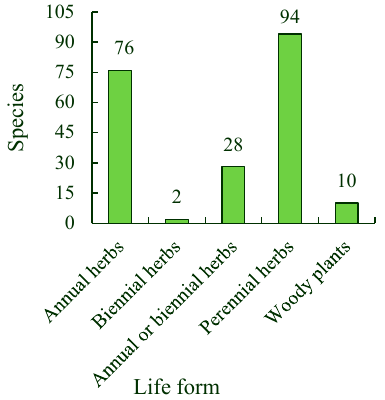
Figure 3. Spontaneous plant species in different life forms.